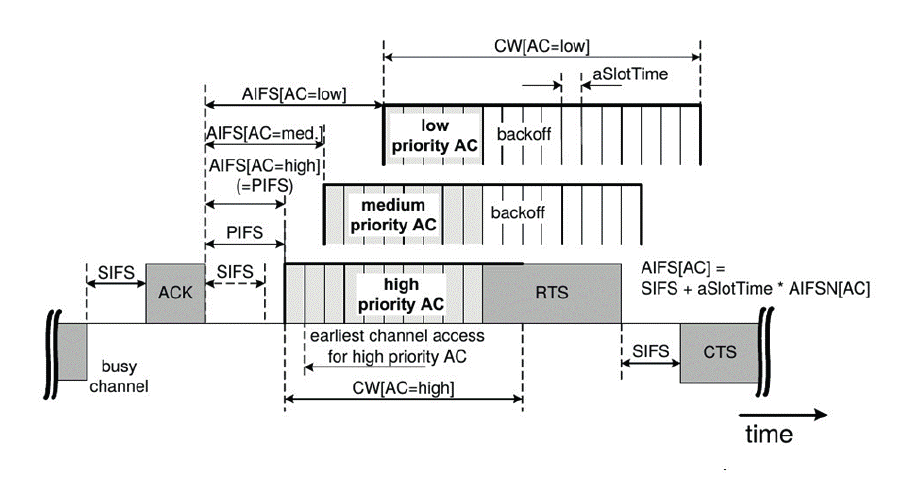
Fig. 3. Multiple backoff entities compete in parallel for channel access with different priorities. The earliest possible channel access time after a busy channel is